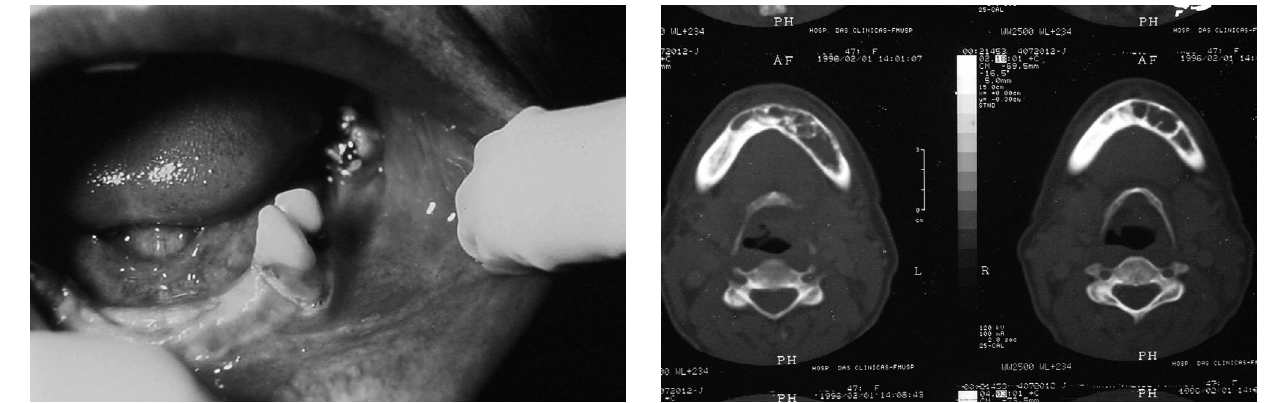
Figure 4 - Computed axial tomography scan showing the lesion with thin residual bony trabeculae or septa dividing the lesion in various compartments and slight expansion of mandibular external cortical